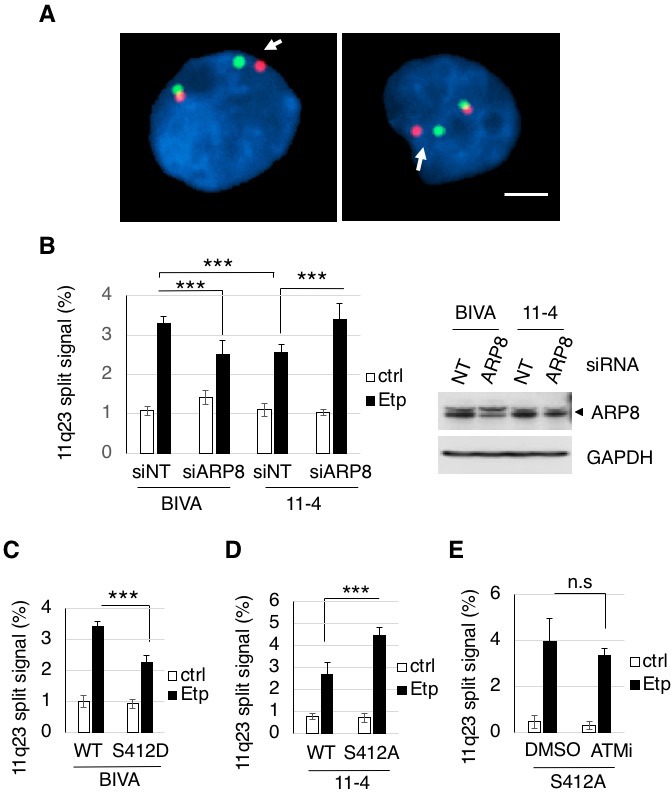
ARP8 phosphorylation averts 11q23 chromosome translocations.(A) Dual-color FISH analysis of chromosome 11q23. Representative FISH images using etoposide treated BIVA cells are shown. Arrows indicate the split signals (separated by >1 µm). Scale bar: 5 μm. (B) The percentages of AT5BIVA or 11–4 cells with split chromosome 11q23 signals are shown. The non-targeting control siRNA (siNT) or siARP8-depleted cells were treated with DMSO (ctrl) or etoposide for 15 min, washed, and cultured for 6 hr in fresh medium. At least 2,000 cells were analyzed in every experiment. The average percentages of cells with split signals from four independent experiments are shown. Values represent the means ± SE. ***p<0.001 as determined by the Z test. The ARP8 knockdown is shown in the gel image on the right. Source data are presented in Figure 5—source data 1. (C, D) Dual-color FISH analyses of chromosome 11q23 using ARP8-depleted AT5BIVA (C) and 11–4 (D) cells expressing the siARP8-resistant ARP8 wild-type (WT), S412D, or S412A. The average percentages of the cells with split signals from three independent experiments are shown. Values represent the means ± SE. ***p<0.001 as determined by the Z test. Source data are presented in Figure 5—source data 1. (E) Dual-color FISH analyses of chromosome 11q23 using 11–4 cells expressing the siARP8-resistant ARP8 S412A. The cells were treated with/without 10 μM ATM inhibitor (KU55933) for 2 hr before etoposide treatment. After the cells were washed, KU55933 (5 μM) was added until the cells were harvested. The average percentages of the cells with split signals from three independent experiments are shown. Values represent the means ± SE from three independent experiments. n.s.: no significant difference. Source data are presented in Figure 5—source data 1.10.7554/eLife.32222.023Figure 5—source data 1.Source raw data for Figure 5B-E.10.7554/eLife.32222.024Figure 5—source data 2.Source raw data for Figure 5—figure supplement 1A and B.